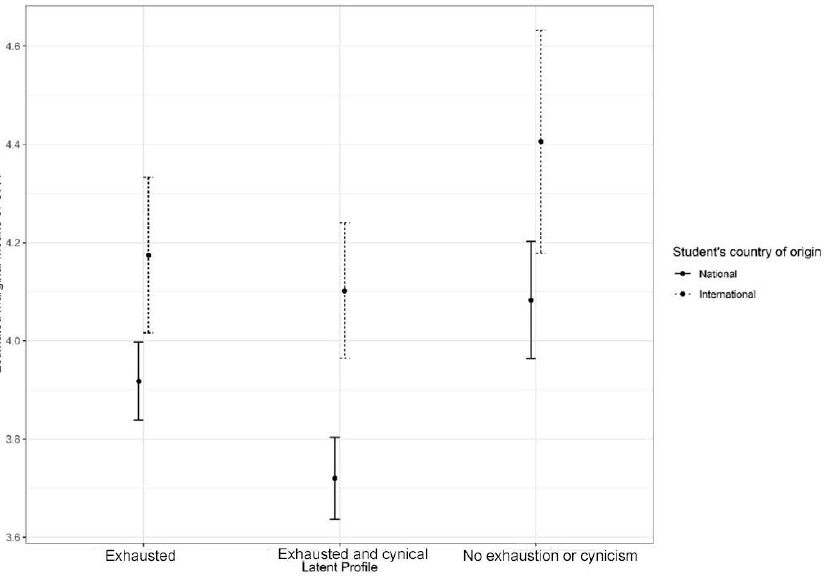
Figure 3. Means of GPAs across the latent profiles for domestic and international students with 95% confidence intervals.